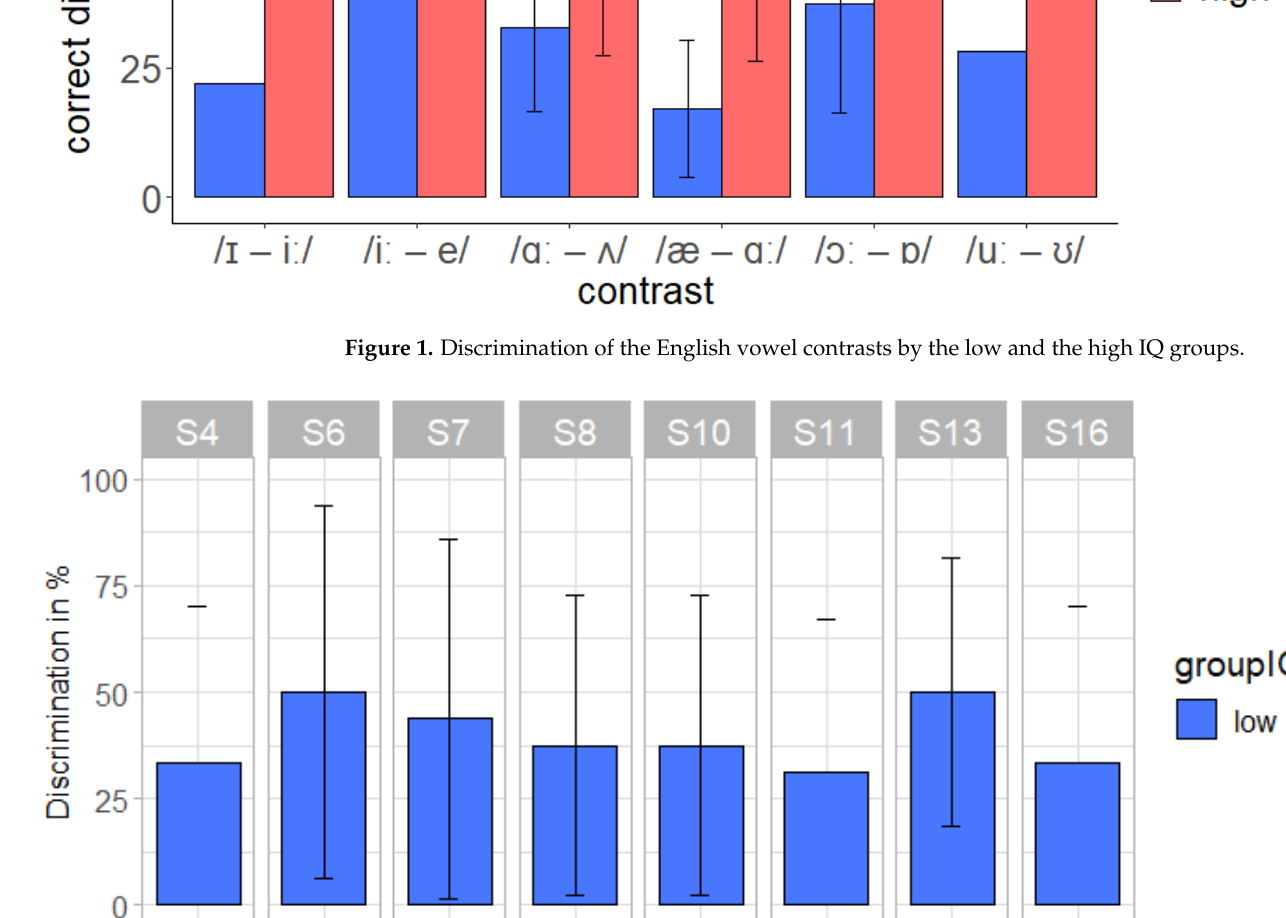
Table 2. Pairwise comparisons for groupIQ:contrast.